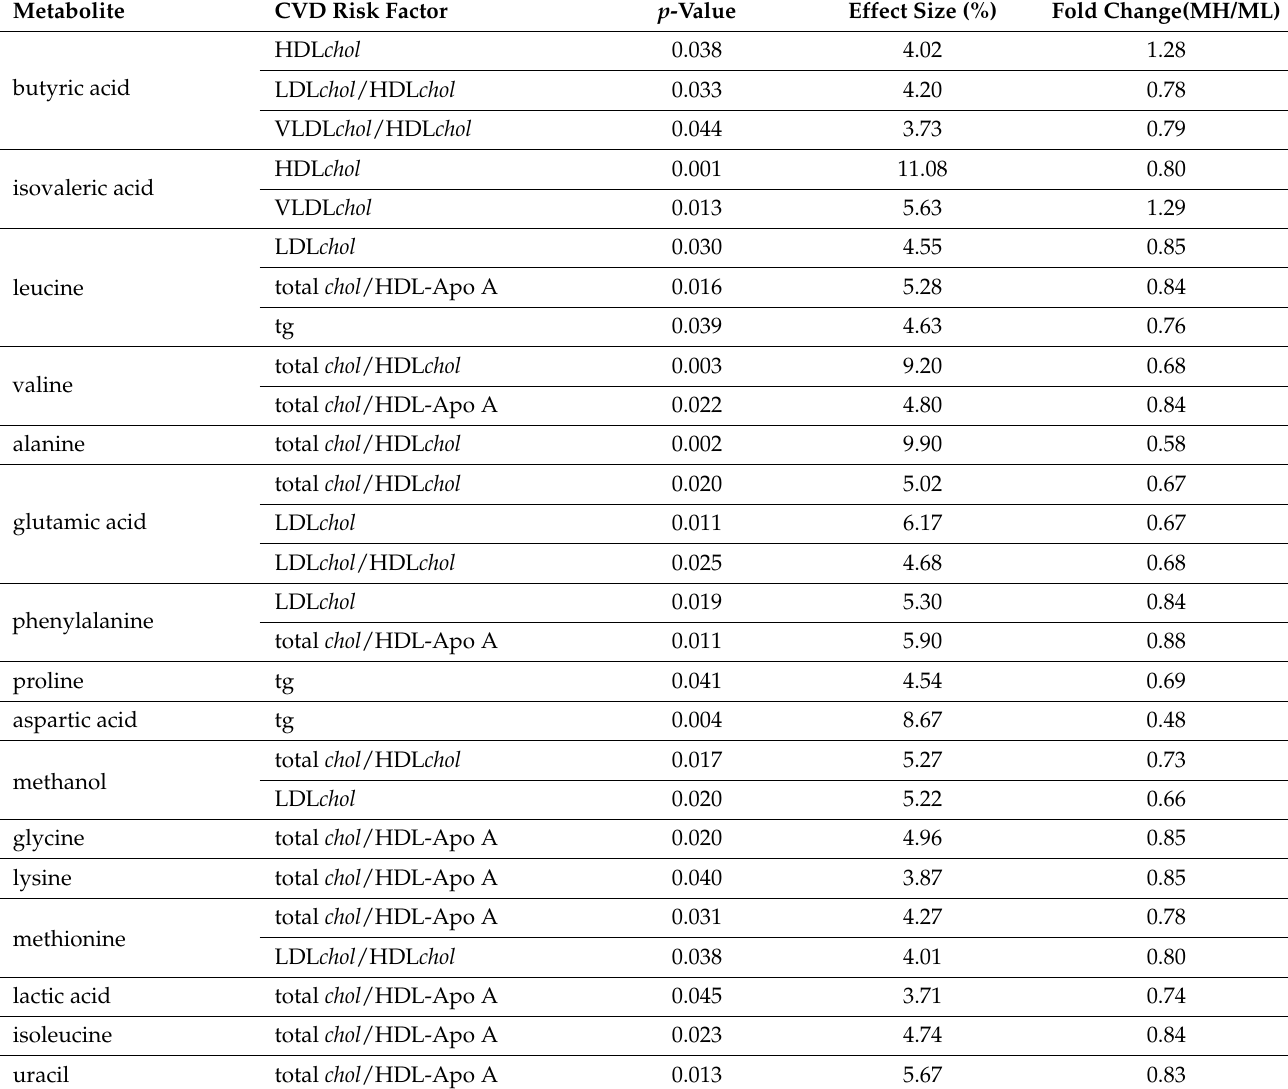
Table 1. A list of human fecal metabolites that have significantly different concentrations in older adults according to their blood plasma concentrations of selected lipoproteins. These lipoproteins included total chol , tg , HDL chol , LDL chol , VLDL chol , and the LP ratios of total chol /HDL chol , total chol /HDL-Apo A, LDL chol /HDL chol , and VLDL chol /HDL chol